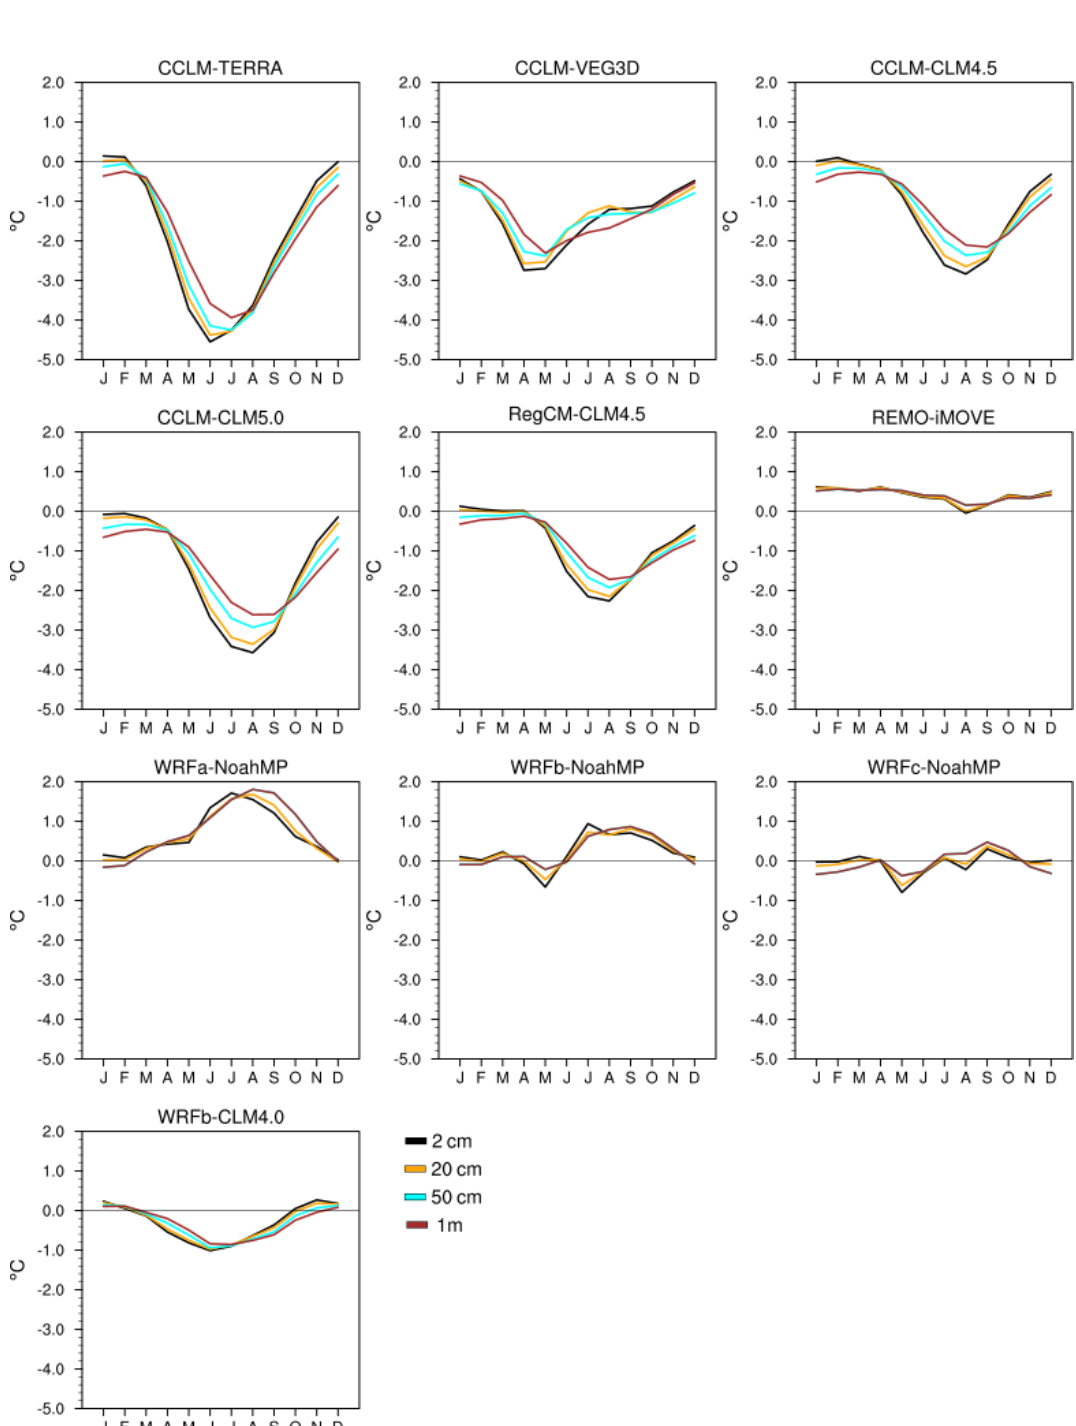
Figure 3. Afforestation impact (FOREST minus GRASS) on mean monthly soil temperature at four different soil depths over the Mediter-